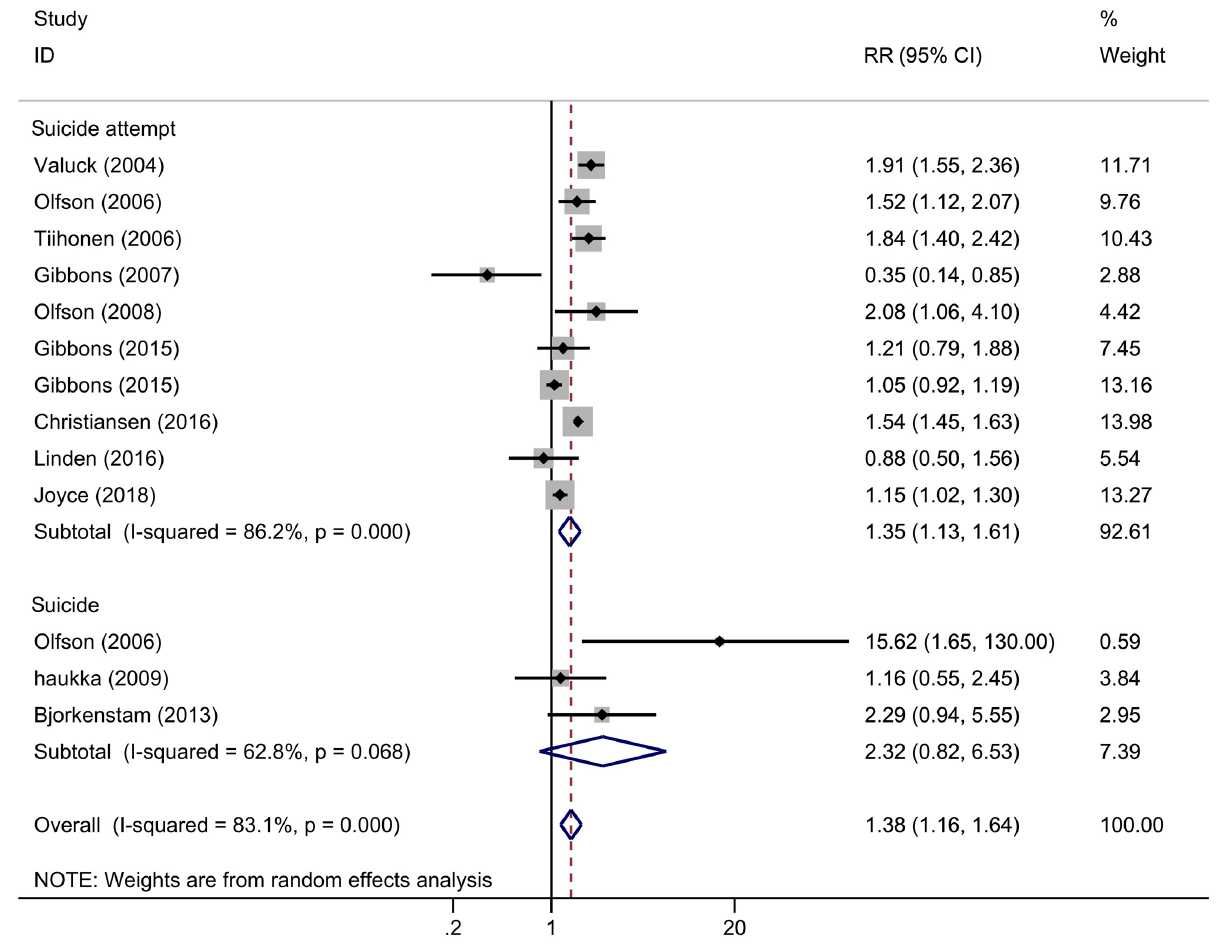
FIGURE 2 | Forest plot of antidepressant exposure and the risk of suicidal behavior among children and